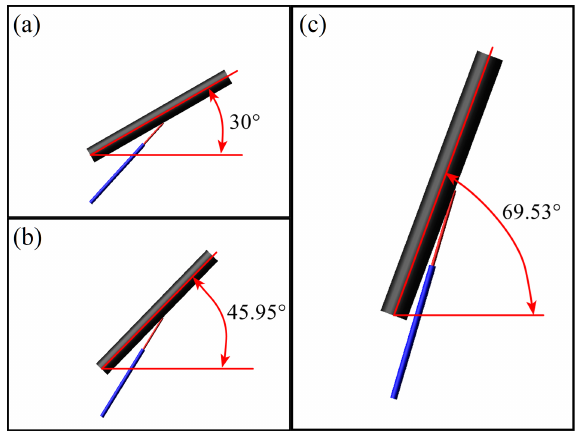
Figure 10. Spatial states of mechanical system: ( a ) x h = 0 mm, ( b ) x h = 100 mm, ( c ) x h = 200